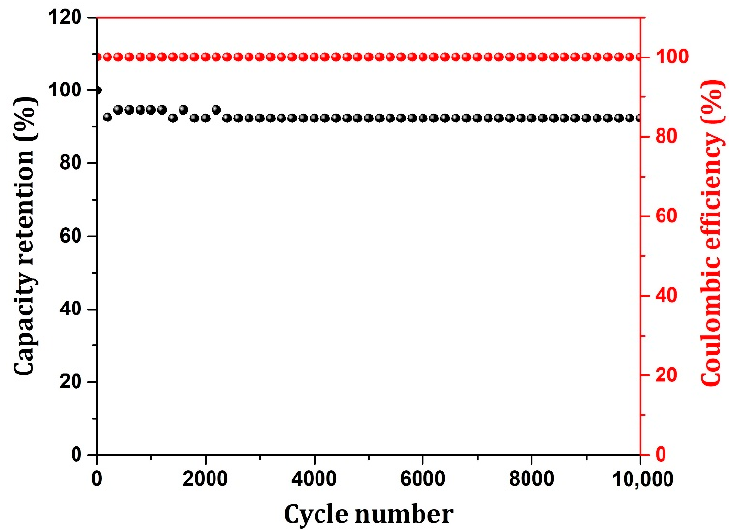
Figure 8. Coulombic efficiency and capacity retention of the device (NiO/Ni//AC).